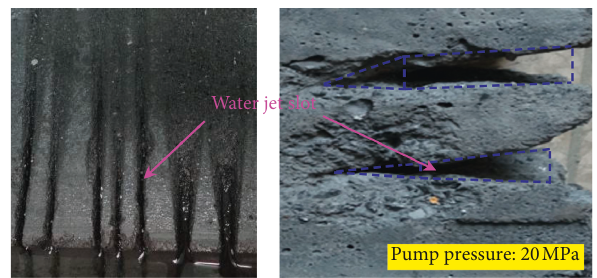
Figure 1: Coal and rock mass cutting using water-only